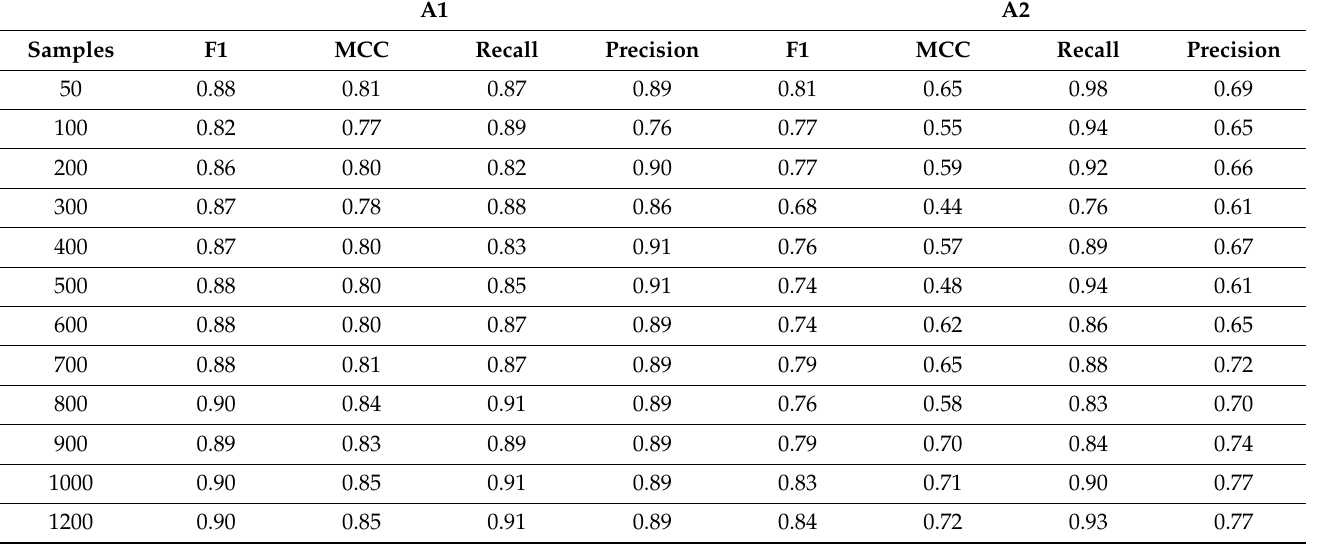
Table 2. Defect detection of solders for A1 and